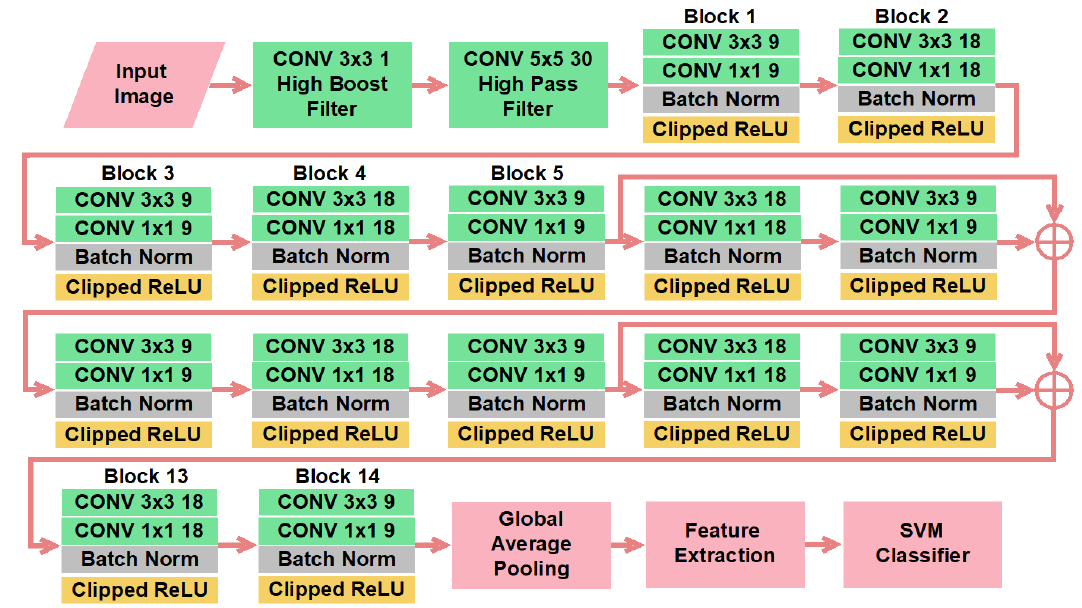
Figure 5. Entropy covariance plots of the cover and stego-images. ( a ) Covariance plot of the cover and HILL. ( b ) Covariance plot of the cover and S-UNIWARD. ( c ) Covariance plot of the cover and WOW.